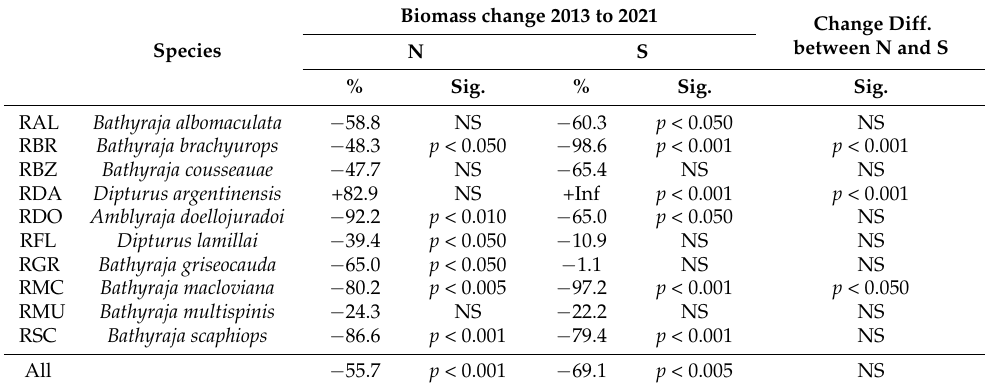
Table 2. Summary of skate species (with FI species codes) captured in the surveys, percentages of biomass change from 2013 to 2021, statistical significances of change within north and south Skate Boxes as well as of the difference between north and south. NS: not significant; p > 0.05. Biomass change 2013 to 2021 Change Diff. between N and SN S Species % Sig. % Sig. Sig. RAL Bathyraja albomaculata − 58.8 NS − 60.3 p < 0.050 NS RBR Bathyraja brachyurops −